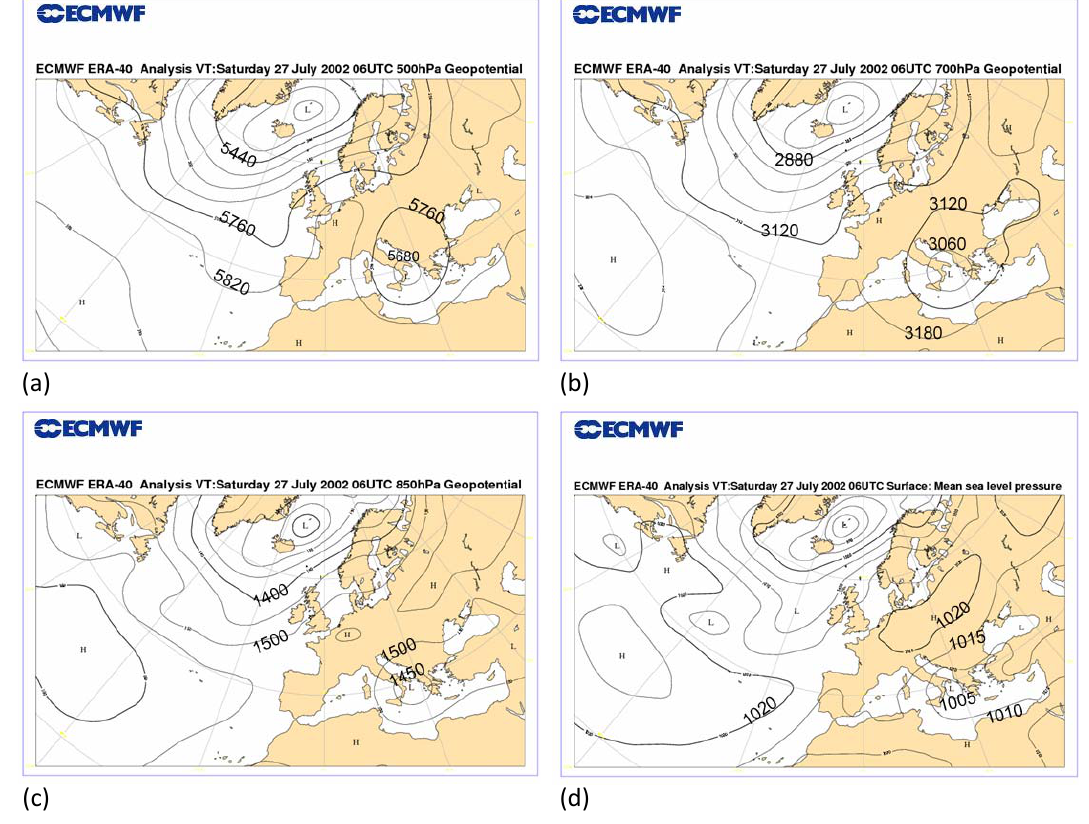
Figure 2. ECMWF reanalysis charts of geopotential heights at: (a) 500hPa, (b) 700hPa, (c) 850hPa and (d) reanalysis of MSL pressure, at 06:00UTC on 27 July